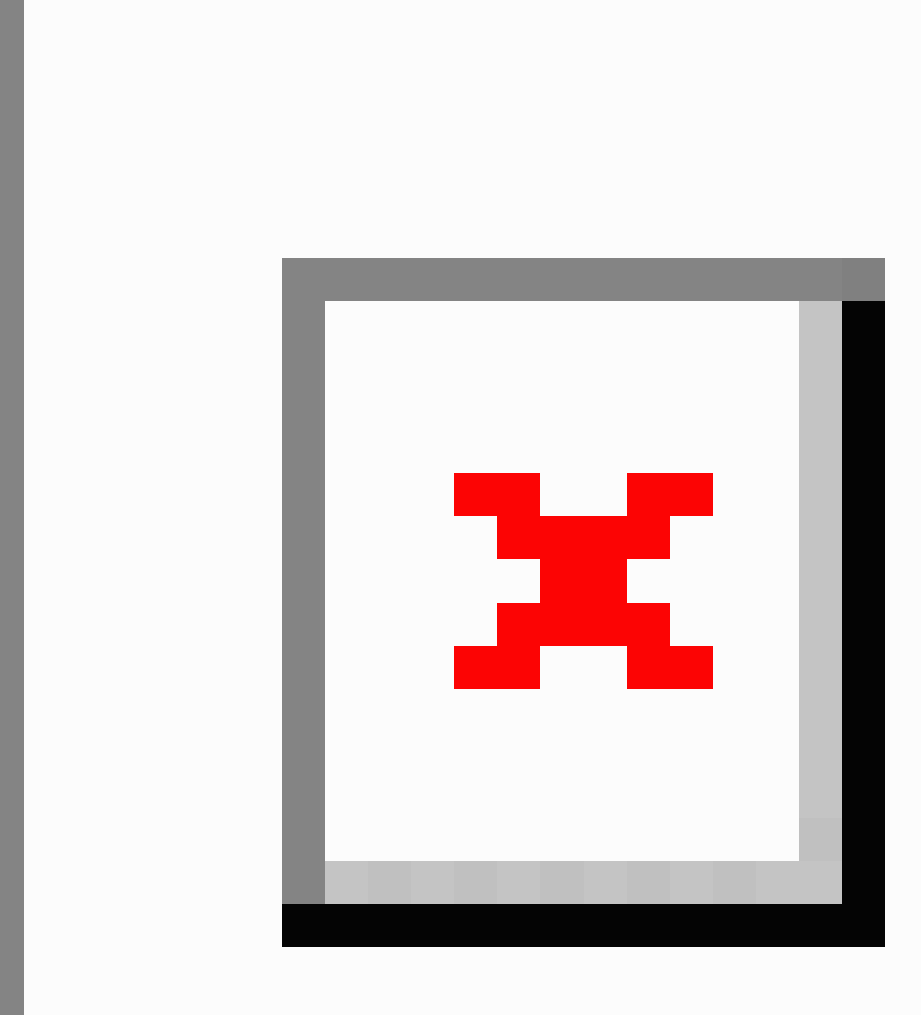
Figure 1. Screenshots of